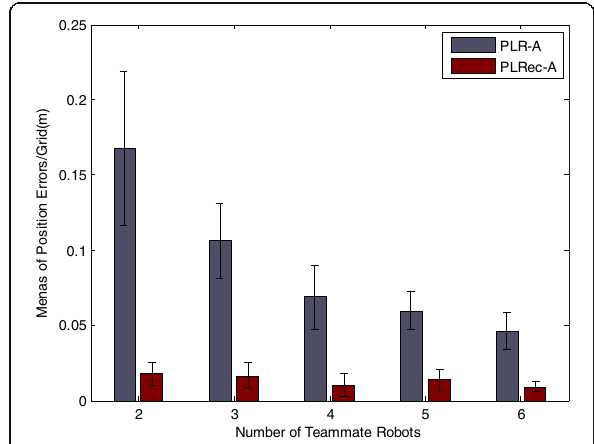
Fig. 3 Localization errors for multi-robot systems of different sizes; in the histogram, left bar and right bar for each team size represent errors of robots coordinated by PLR-A and PLRec-A, respectively